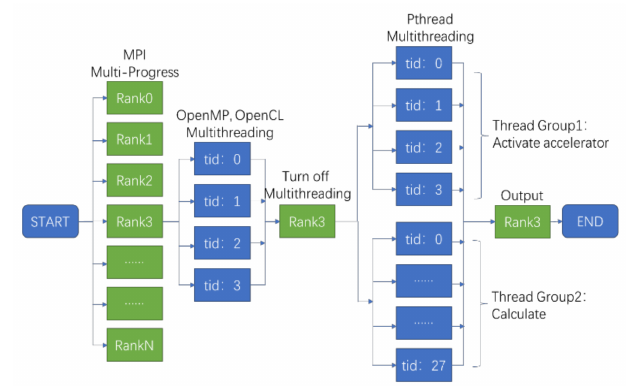
Figure 3. Schematic of the heterogeneous parallel